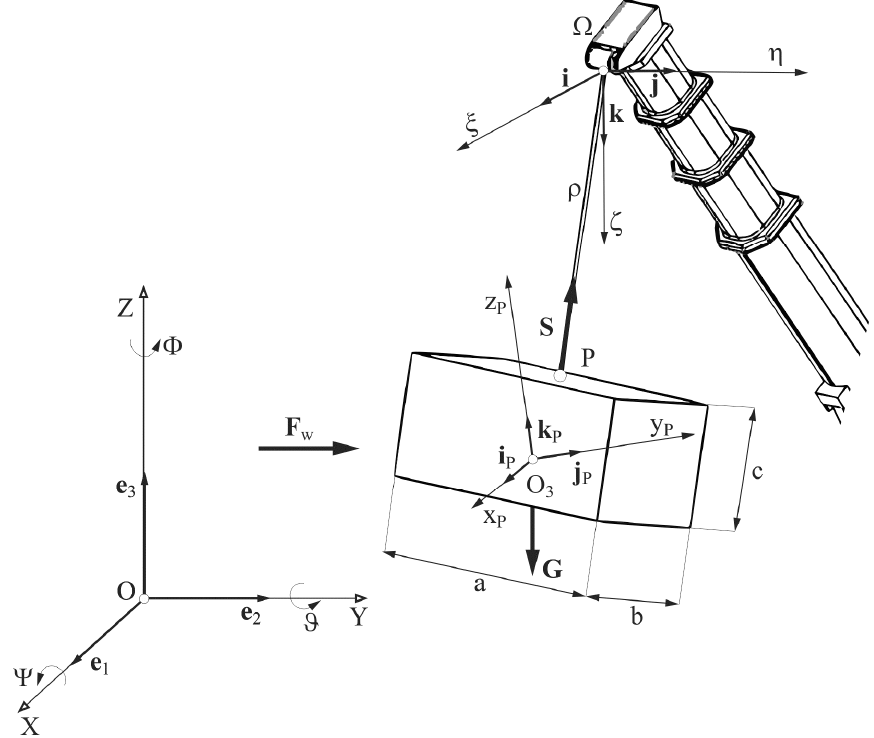
Figure 2. Forces acting on the load during the work cycle.